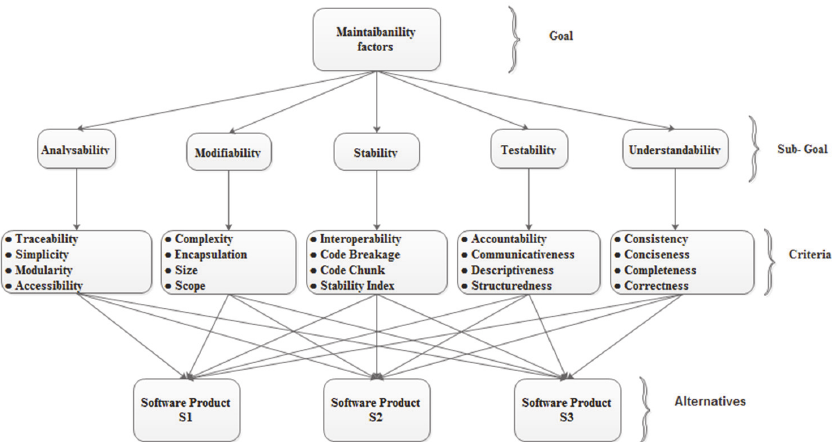
Fig. 3. Hierarchical Structure of maintainability